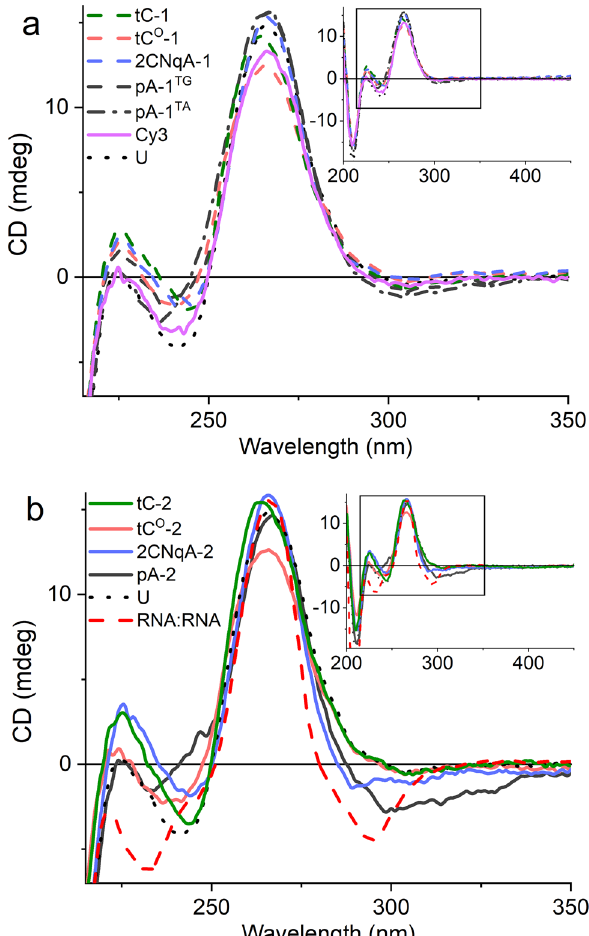
Figure 2. Circular dichroism (CD) spectra of tC (green), tC O (red), 2CNqA (blue), pA (dark gray), Cy3 (violet), and unmodified U (black dotted line) gapmers hybridized to the RNA target T. The duplex concentration was 4 µM and the spectra were collected at 10–15 °C to ensure full hybridization. Insets: A zoom-out indicating the region (black rectangle) of the main figure. ( a ) Single-labeled gapmers. ( b ) Double-labeled gapmers. To illustrate the similarity to the A-form CD signature, an RNA:RNA duplex (red dashed line, normalized, see Material and Methods section for sequence) is